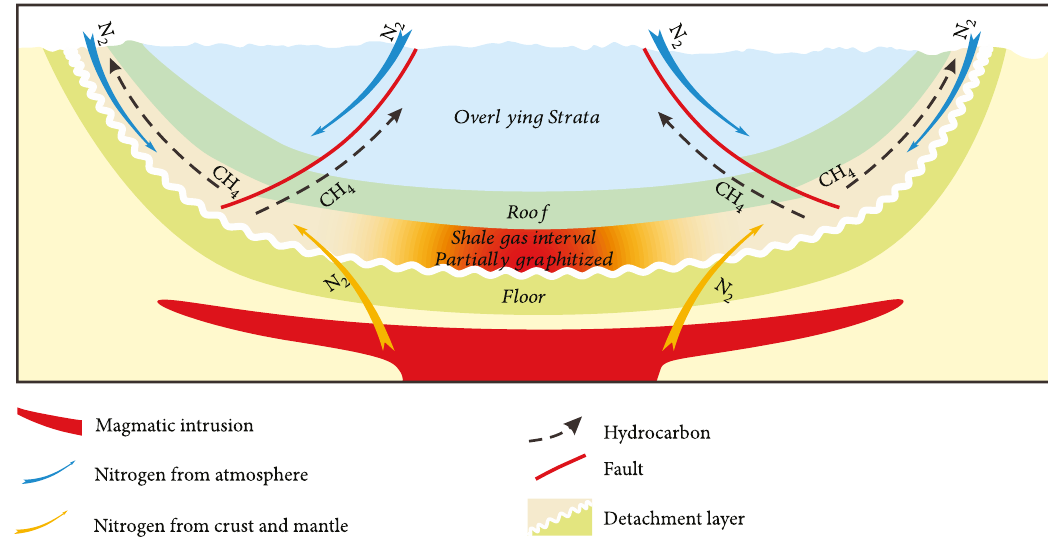
Figure 13: An explanation model for the destruction of shale gas reservoirs and the nitrogen concentration in the study